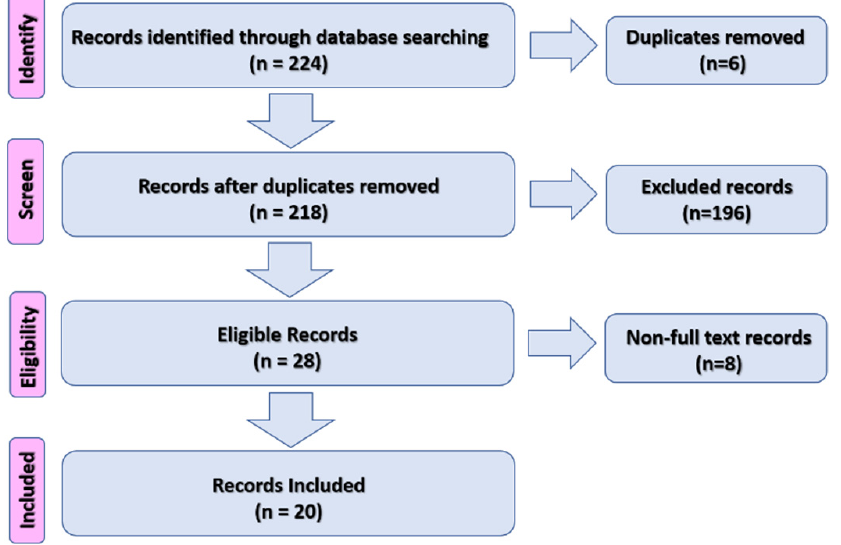
Figure 1. Flow chart of the study procedures.